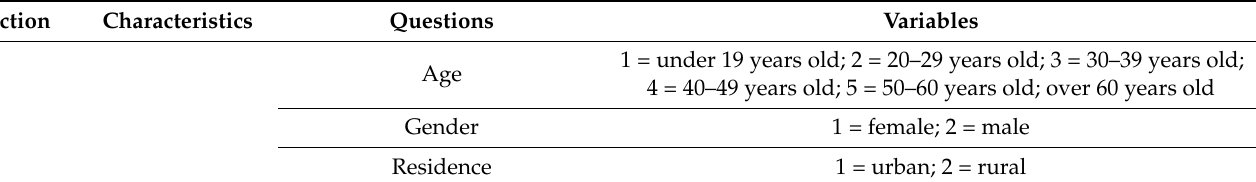
Table 1. Questionnaire framework: the codification of the